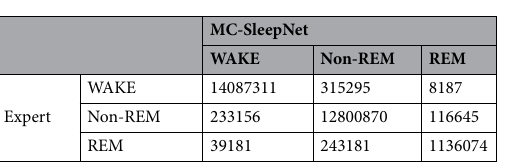
Table 2. Confusion matrix for large-scale